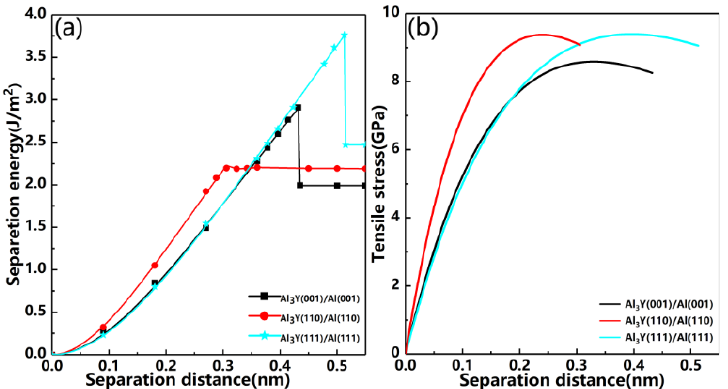
Figure 12. Separation energy and tensile stress versus the separation distance in the relaxation method. ( a ) Separation energy, ( b ) Tensile stress. method. ( a ) Separation energy, ( b ) Tensile stress. Table 6. Separation distance ( D sep ), maximum separation energy ( E fra ), and maximum tensile stress ( σ max ) of the